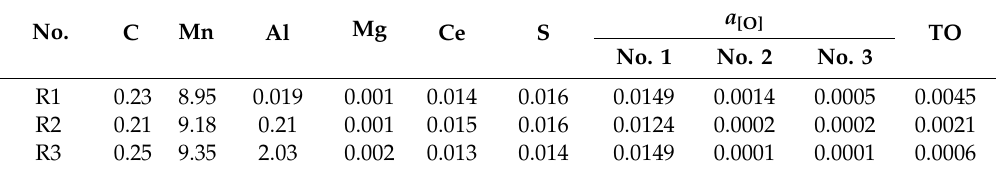
Table 2. Chemical composition of experimental steels (mass fraction / %).